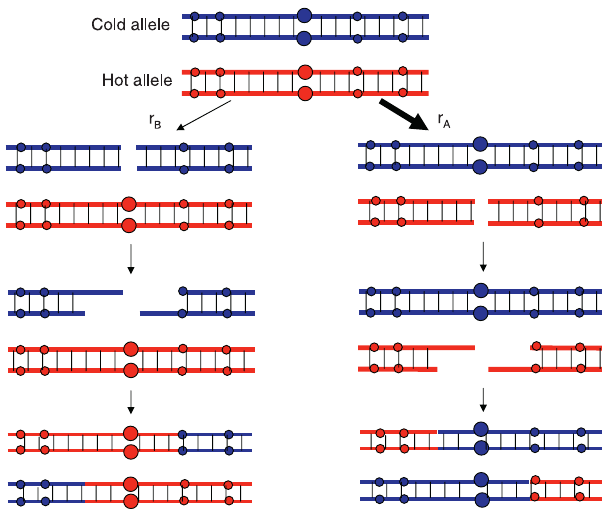
Figure 1. A Simple Representation of the Occurrence and Resolution of a DSB into a Crossover Event during Meiosis In a heterozygote for a hotspot and nonhotspot allele (large red and large blue dots respectively), two nonsister chromatids of the four chromatids present at meiosis are shown. A DSB on the chromatid bearing (red) or not bearing (blue) the hotspot allele occurs with probabilities r A and r B , respectively. In this case, the material immediately surrounding the DSB is lost, and in repairing the break by gene conversion (accompanied by crossing over in this example) the sequence from the other, nonsister, chromatid is used. This results in a bias towards transmission of the non-hotspot allele, proportional to the difference r A (cid:2) r B in initiation rates. The figure could also be drawn to show gene conversion without crossing over, which does not result in exchange of markers (smaller dots) flanking the